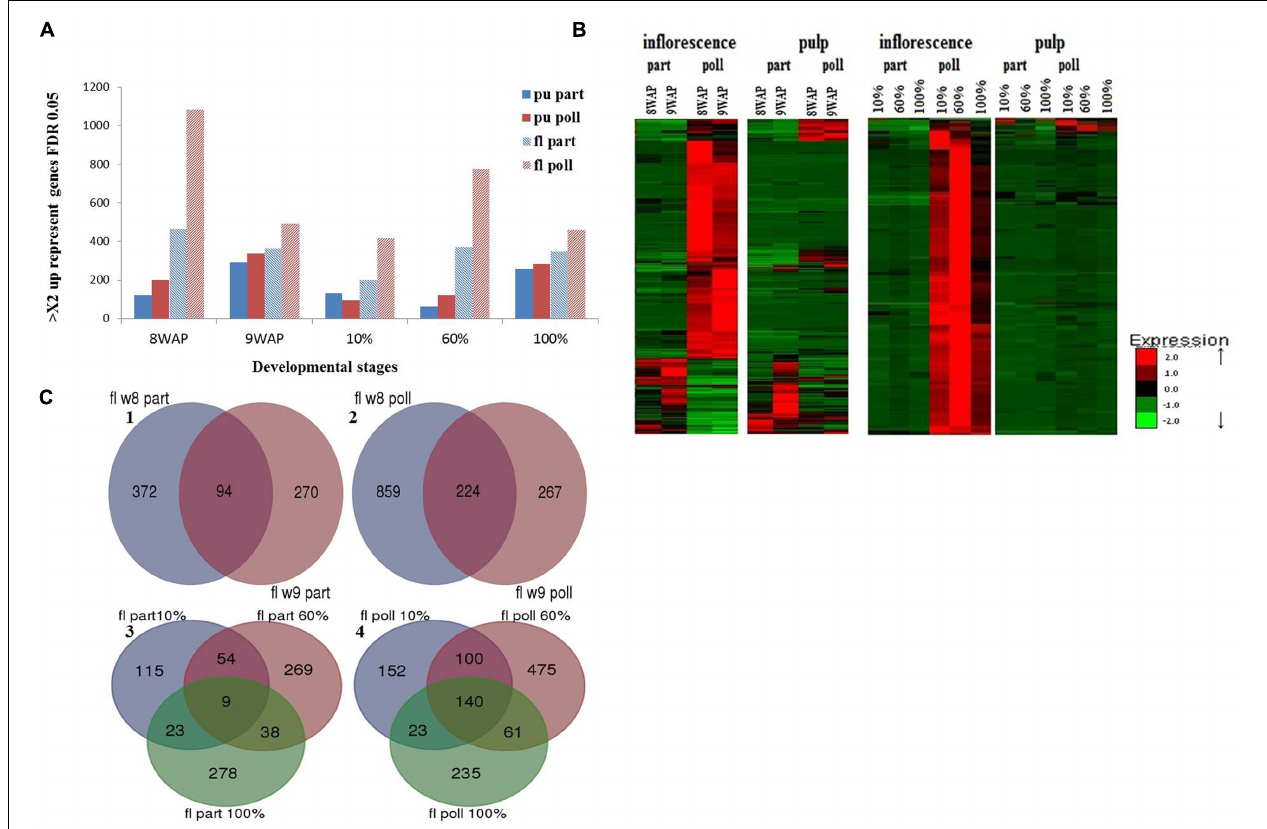
FIGURE 2 | Differentially expressed genes in fruit pulp vs. inflorescence at the five developmental stages. (A) Number of parthenocarpic- (part; blue) and pollination-induced (poll; red) genes, FDR < 0.001, > 2 fold higher expression (FPKM) levels. (B) Heat map of the upregulated genes in parthenocarpic and pollinated pulp and inflorescence. (C) Venn diagram of upregulated genes in the inflorescence during: (1) parthenocarpic phase II, (2) pollinated phase II, (3) parthenocarpic phase III, (4) pollinated phase III.